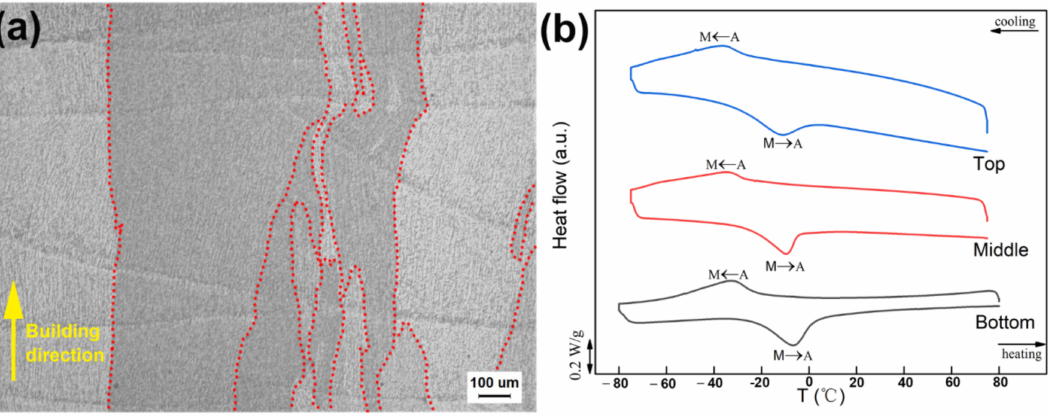
Figure 3. ( a ) Metallographic photos and ( b ) DSC curves of the bottom, middle, and top positions along the deposition